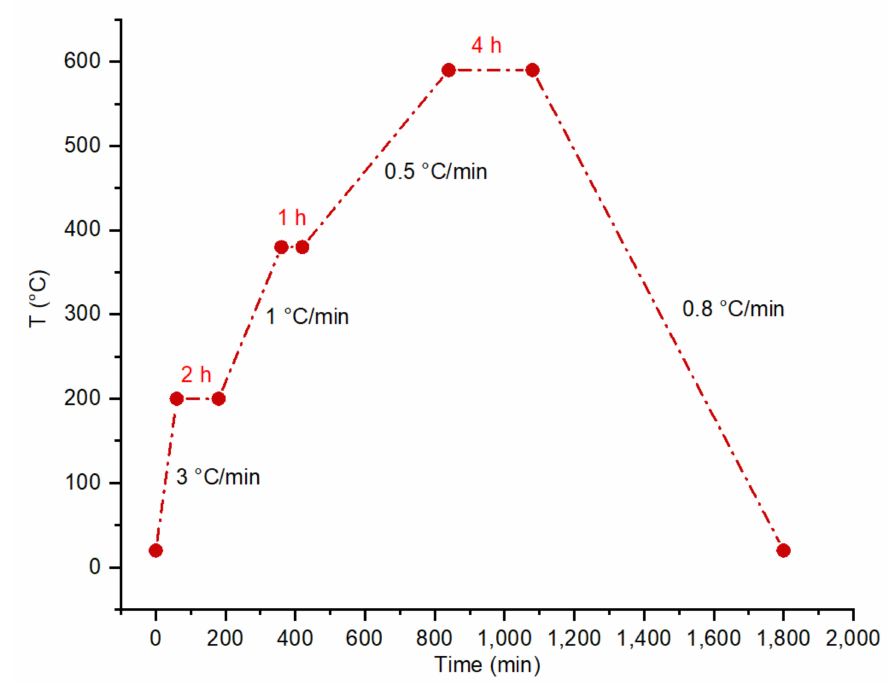
Figure A1. The carbonization protocol for CMSMs (Carbon Molecular Sieve Membranes).